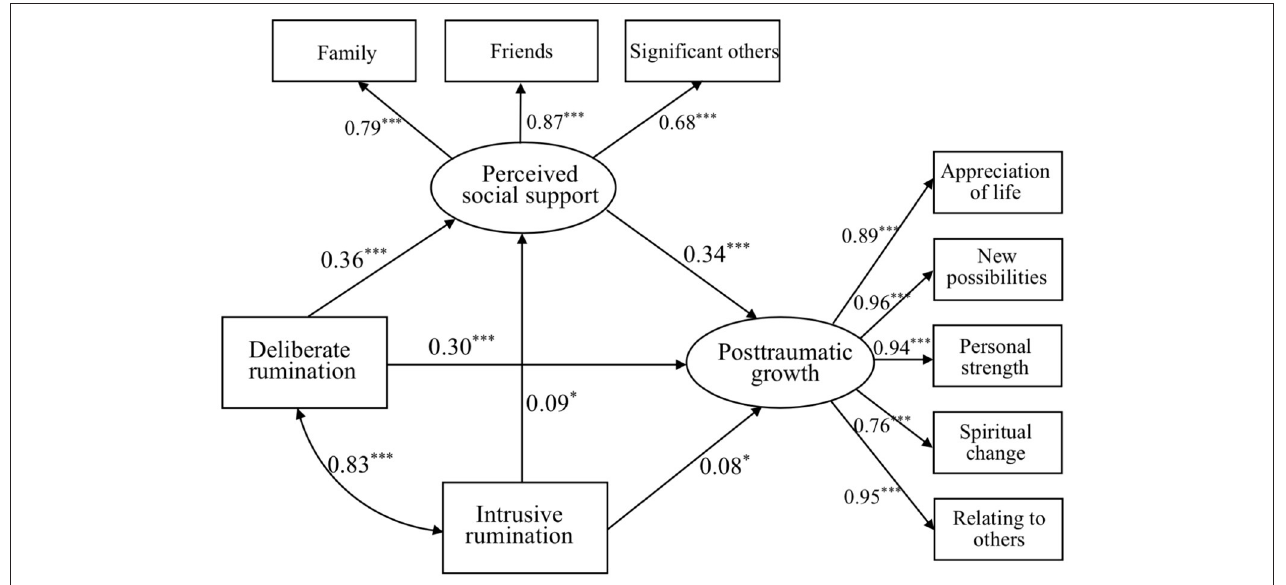
FIGURE 1 | Mediation model of deliberate and intrusive ruminations to PSS and to PTG. * p < 0.05, ** p < 0.01, and *** p < 0.001.